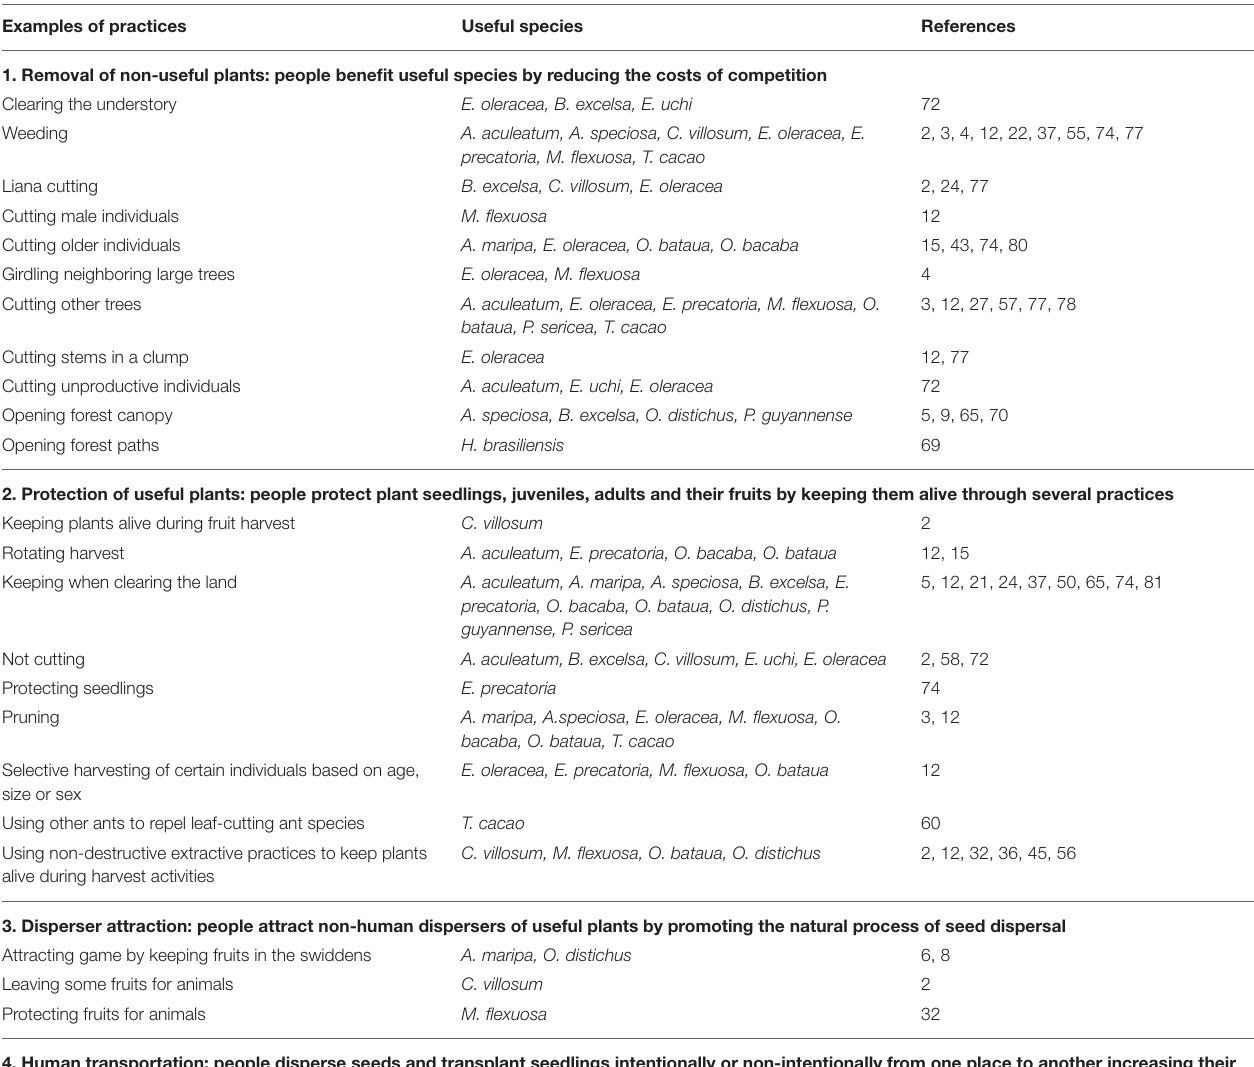
TABLE 1 | Examples of all management practices classified into eight